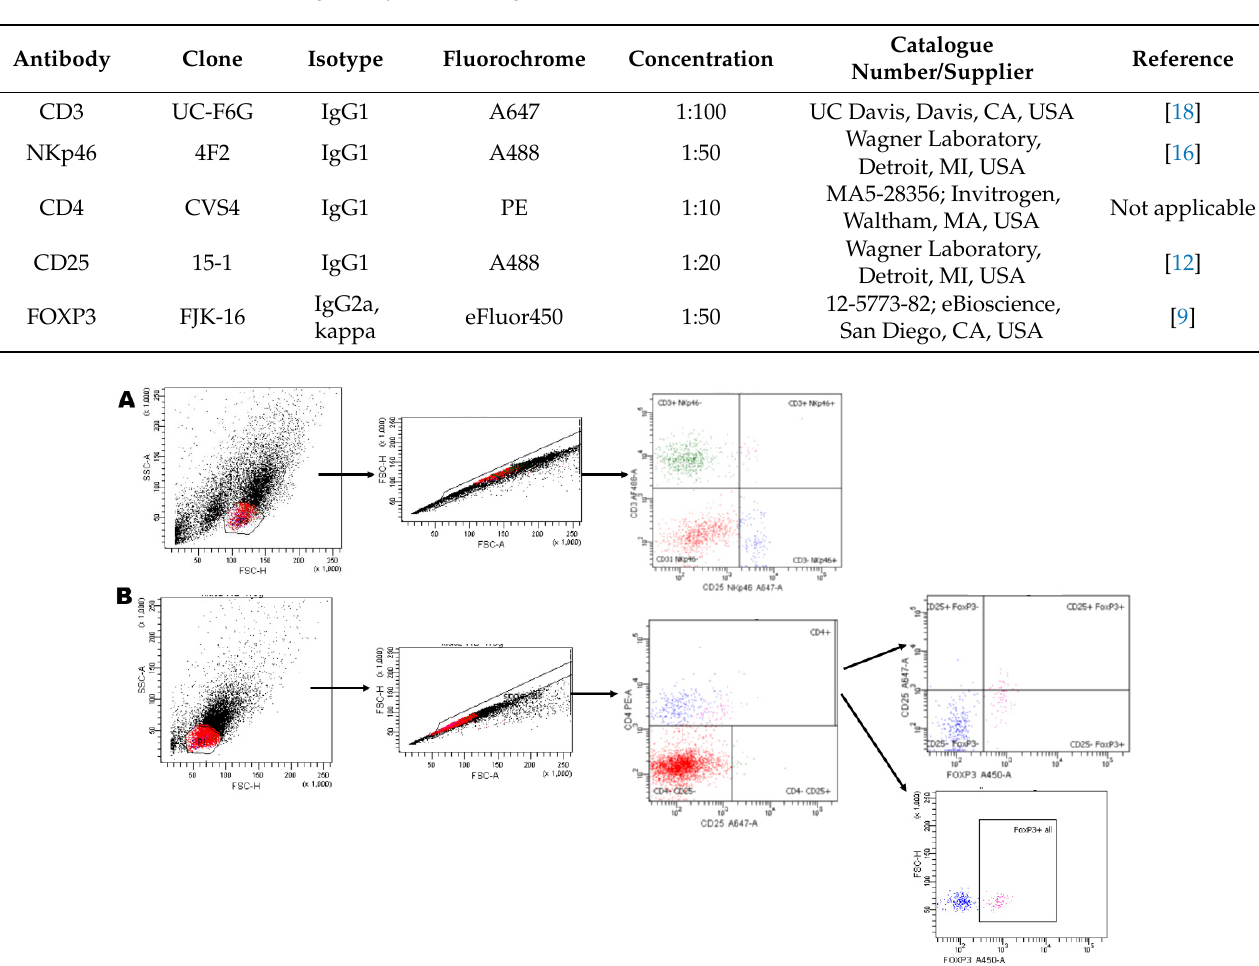
Table 1. Antibodies used in flow cytometry analysis to determine the presence of NK cells and reg- ulatory T cells (Tregs) in mares’ endometrium.